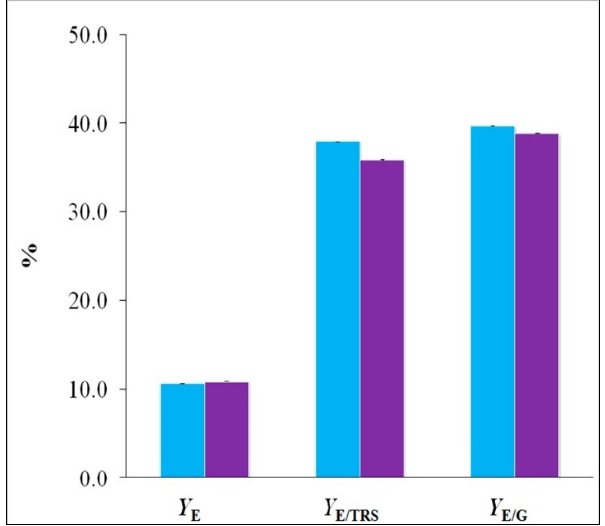
Figure 7. Ethanol yields in relation to initial raw material ( Y E ) and overall ethanol yields respect TRS and D -glucose consumption ( Y E/TRS , Y E/G ), for young ( ) and old ( ) fibers during fermenta- tion process.